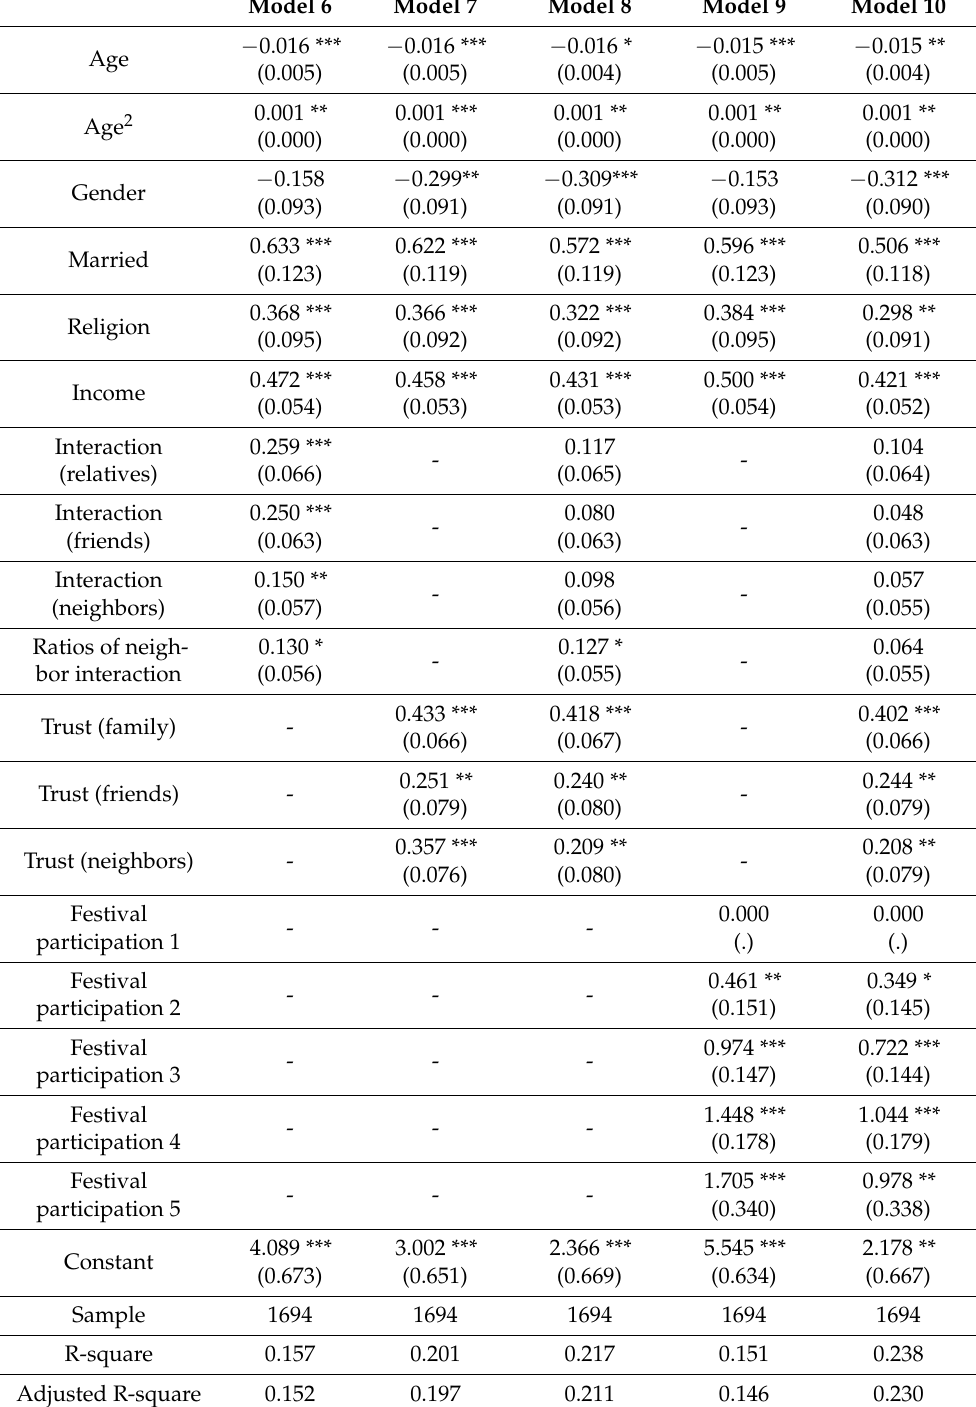
Table 3. Influences of social capital and festival participation on life